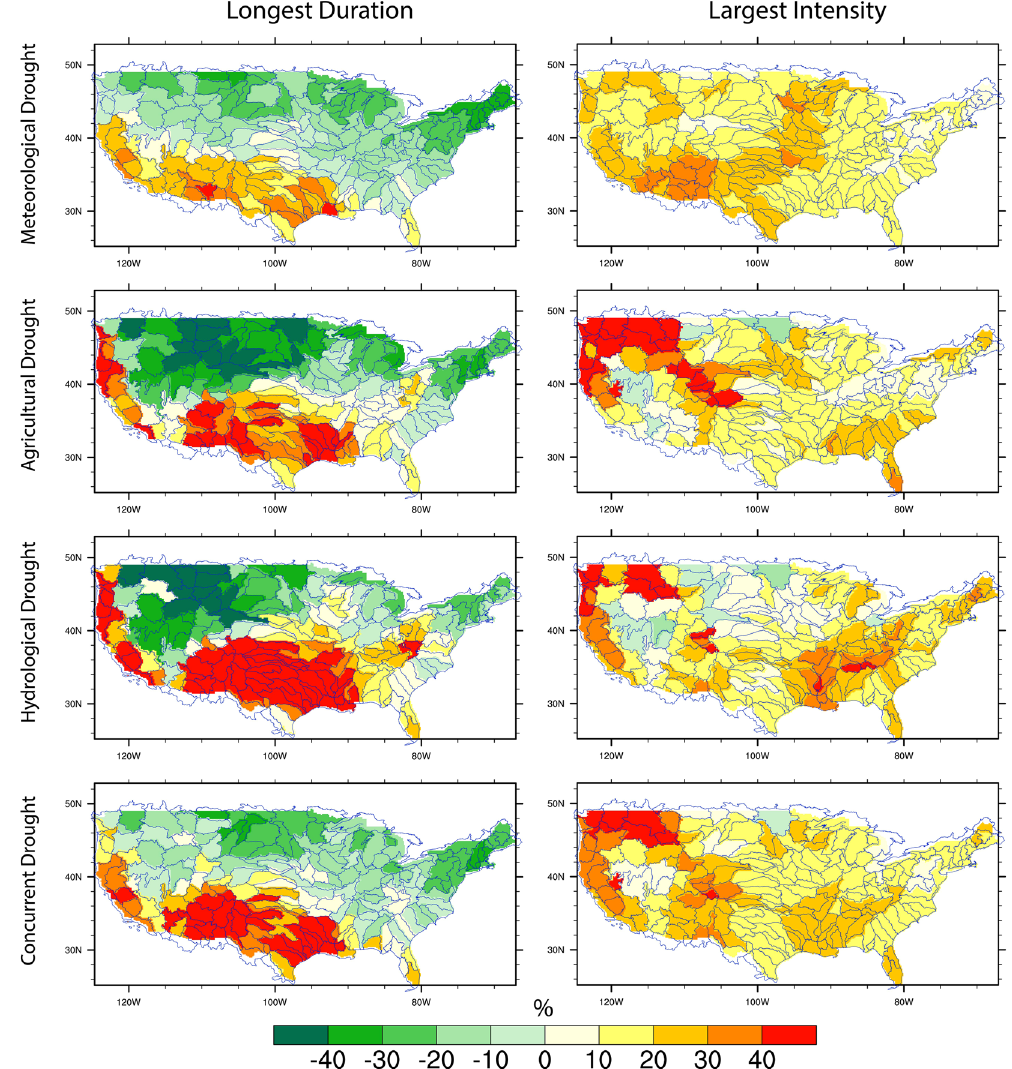
Figure 7. Multi-model ensemble mean changes (%) in the longest duration and largest intensity (i.e., the most negative drought intensity) of meteorological, agricultural, hydrological and concurrent droughts in 1.5 °C global warming. The global mean temperature is first calculated for each 30-year time window. We select the first 30-year period when the + 1.5C global warming is crossed for each climate model under each RCP. We then calculate the drought changes in the selected period corresponding to a 1.5C warming world for each model and the multi-model ensemble mean under each RCP is shown. Figure was created by NCAR Command Language 81